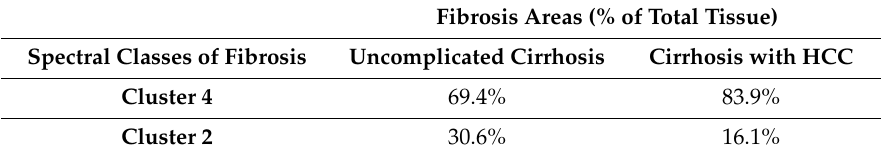
Table 1. Comparison of the distribution of the two spectral classes corresponding to fibrosis areas